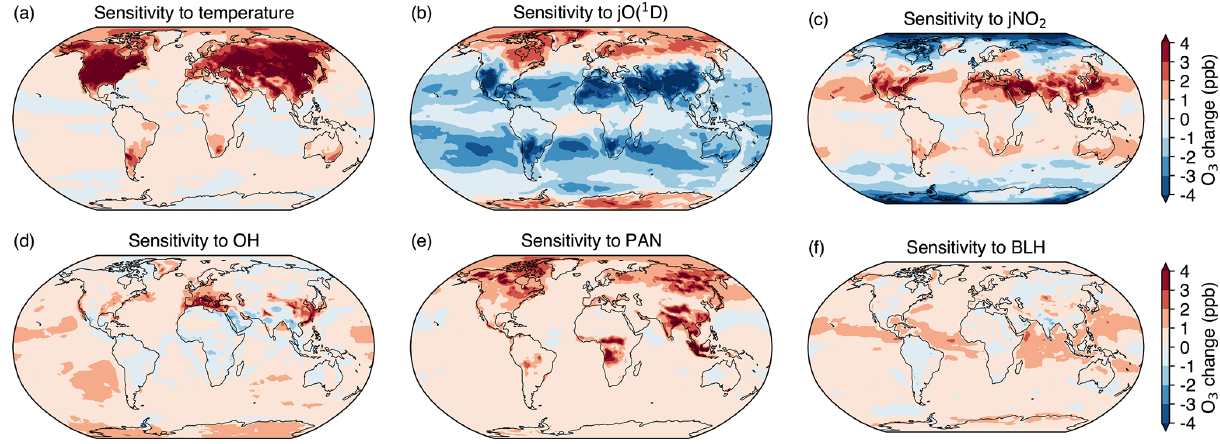
Figure 6. Sensitivity of annual mean surface O 3 bias to increases in (a) temperature, (b) j O( 1 D), (c) j (NO 2 ), (d) OH, (e) PAN and (f) BLH. Variable values are increased by 0.5 standard deviations of their temporal variability for each UKESM1 grid cell